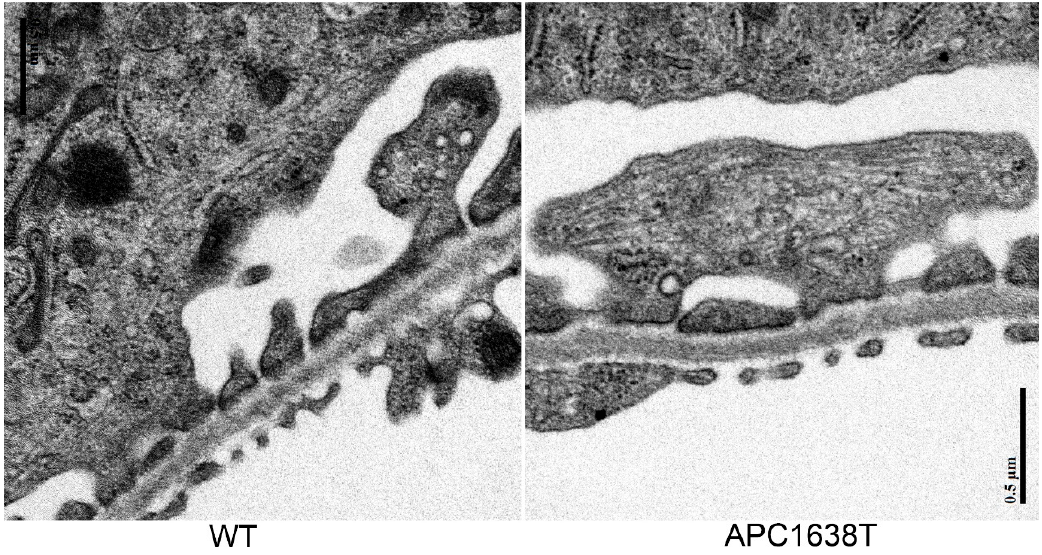
Figure 3. Electron micrograph of podocyte of wild-type (WT) and APC1638T mice. The bar indicates 0.5 μ m.